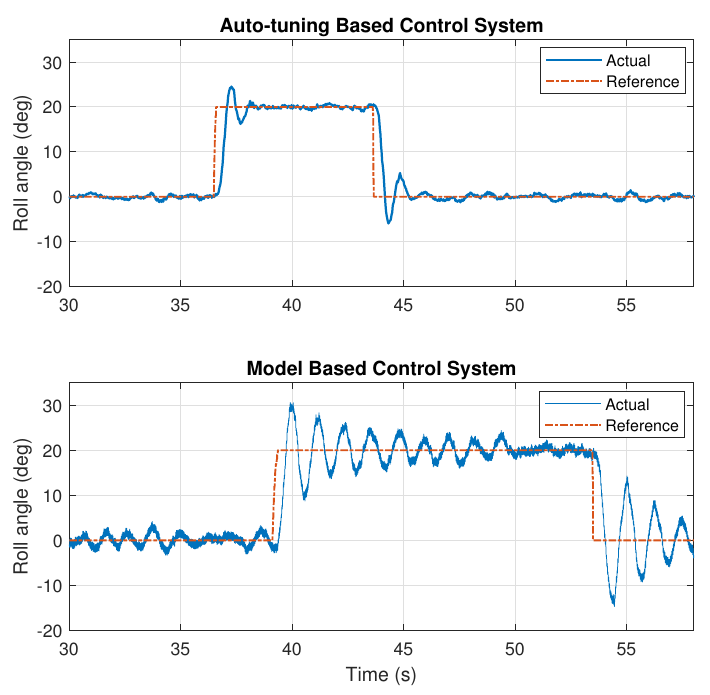
Figure 29. Control performance